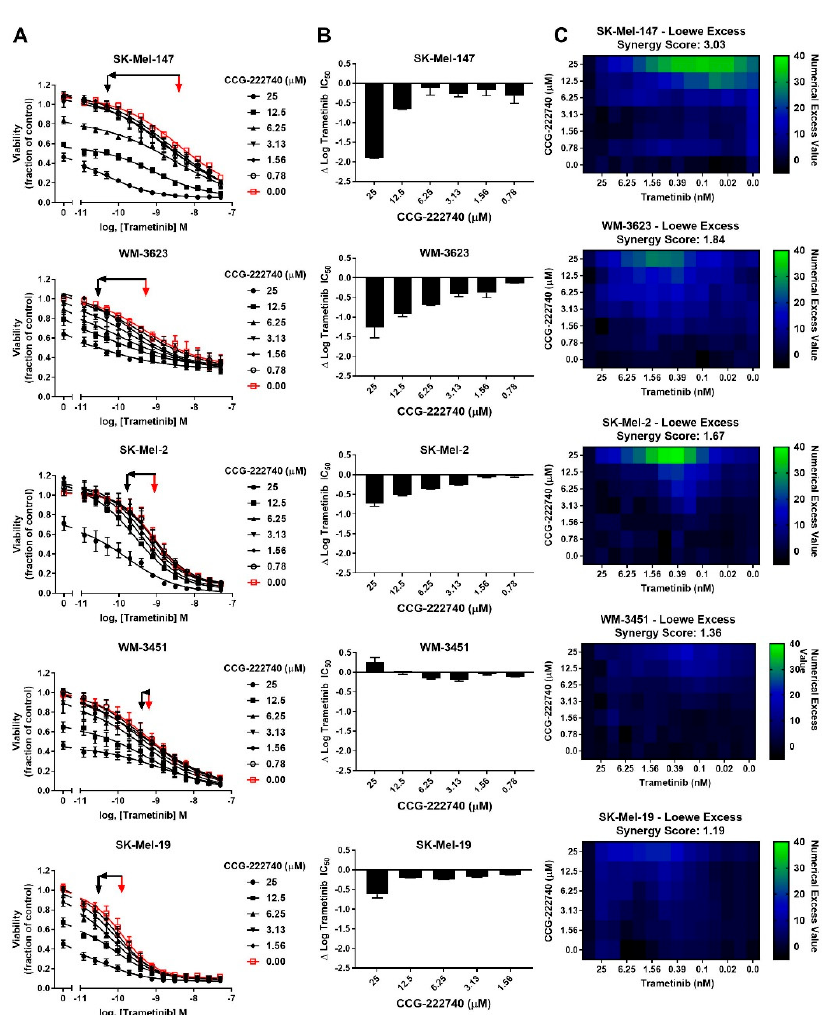
Figure 3. MRTF-pathway inhibition synergizes with trametinib to inhibit NRAS mutant melanoma cell viability. ( A ). Sensitivity to CCG-222740 and trametinib in combination was determined by treating each cell line with increasing concentrations of trametinib in the presence of a range of concentrations of CCG-222740. Cell viability at 72 h was determined using Cell-TiterGLO ® . Viability is expressed as the fraction of luminescence over vehicle control. For SK-Mel-19 and SK-Mel-147, n = 4, for the other lines n = 3. The red arrow indicates the logIC50 of trametinib in the absence of CCG-222740, and the black arrow indicates the logIC50 of co-treatment conditions that displayed the greatest leftward shift in the trametinib concentration response curve (12.5 nM or 25 nM CCG-222740). ( B ). ∆ logIC50 of trametinib is determined as the difference between the logIC50 of trametinib in the absence and at the indicated concentration of CCG-222740. ( C ). Loewe Excess was utilized as a metric of synergistic effects of the combination treatments. Loewe Excess was determined by detecting Numerical Excess Values (see Methods Section 4.2). Expressed values represent the mean of at 3–4 independent